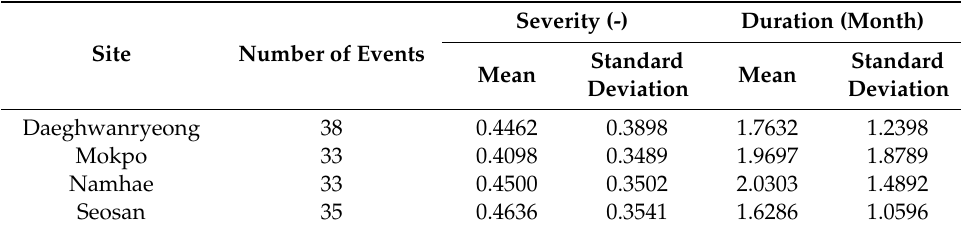
Table 3. Statistics of drought events.